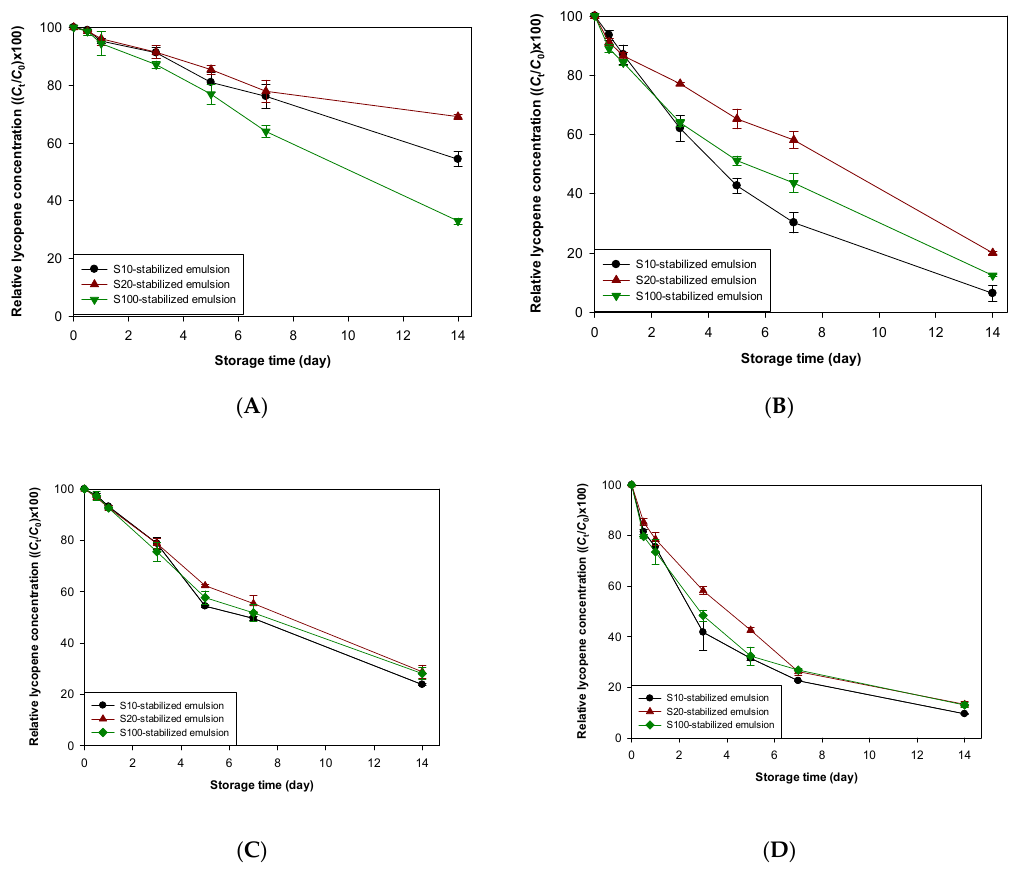
Figure 2. Change in lycopene concentration over storage time in emulsions stored at 25 °C at pH 7 ( A , C ) and 3 ( B , D ) in the absence ( A , B ) and presence ( C , D ) of water-soluble radicals. C 0 , initial lycopene concentration in emulsion; C t , lycopene concentration in emulsion at t day of storage. Table 1. E ff ect of pH and water-soluble free radicals on the degradation rate constant ( k ) of lycopene in emulsions.